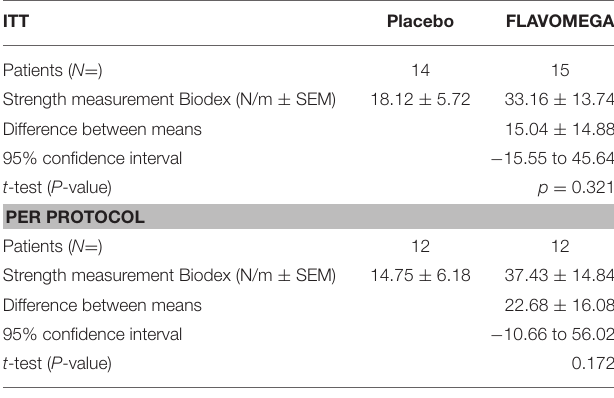
TABLE 5 | Global strength of all included patients at baseline.